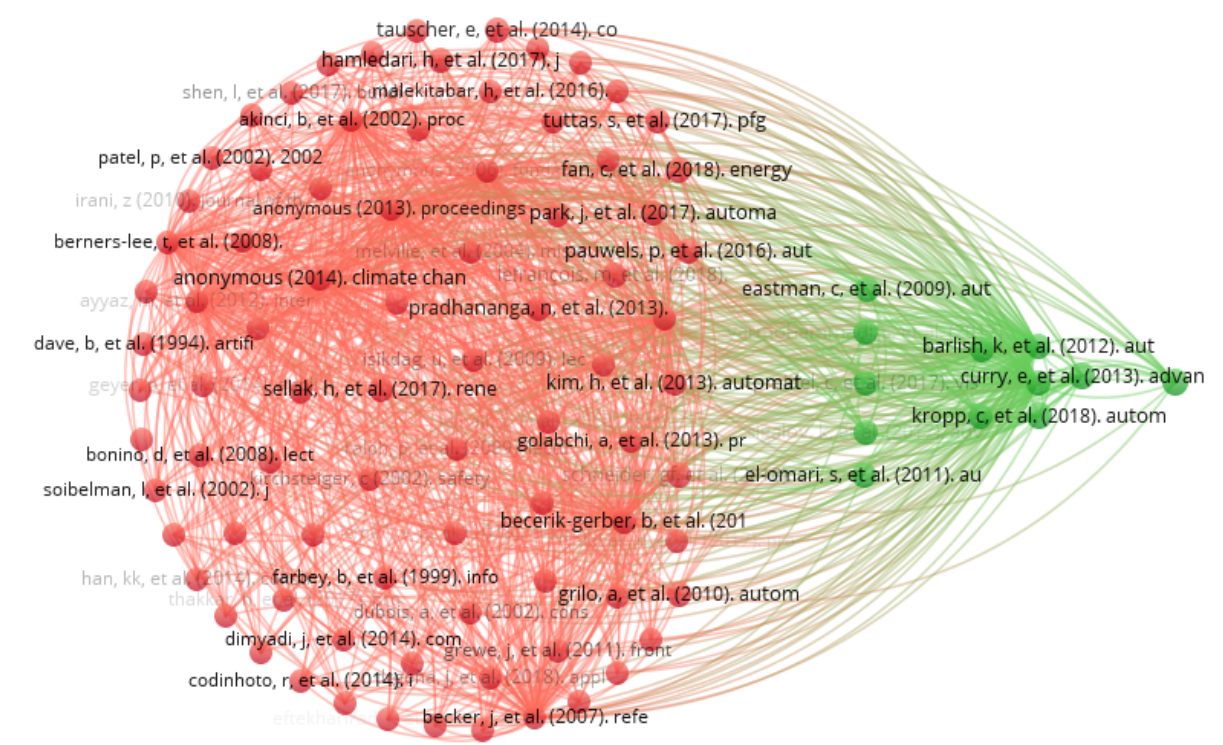
Figure 4. VOSviewer mapping of big data management algorithms, deep learning-based object detection technologies, and geospatial simulation and sensor fusion tools in the Internet of Robotic Things regarding co-citation.